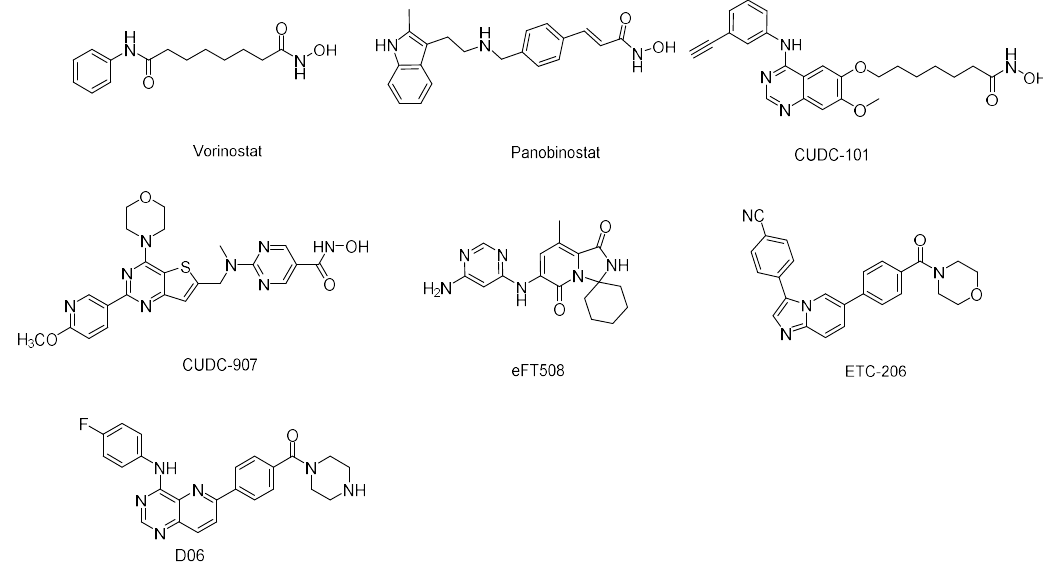
Figure 1. Representative HDAC inhibitors, dual HDAC/kinase inhibitors and Mnk inhibitors.